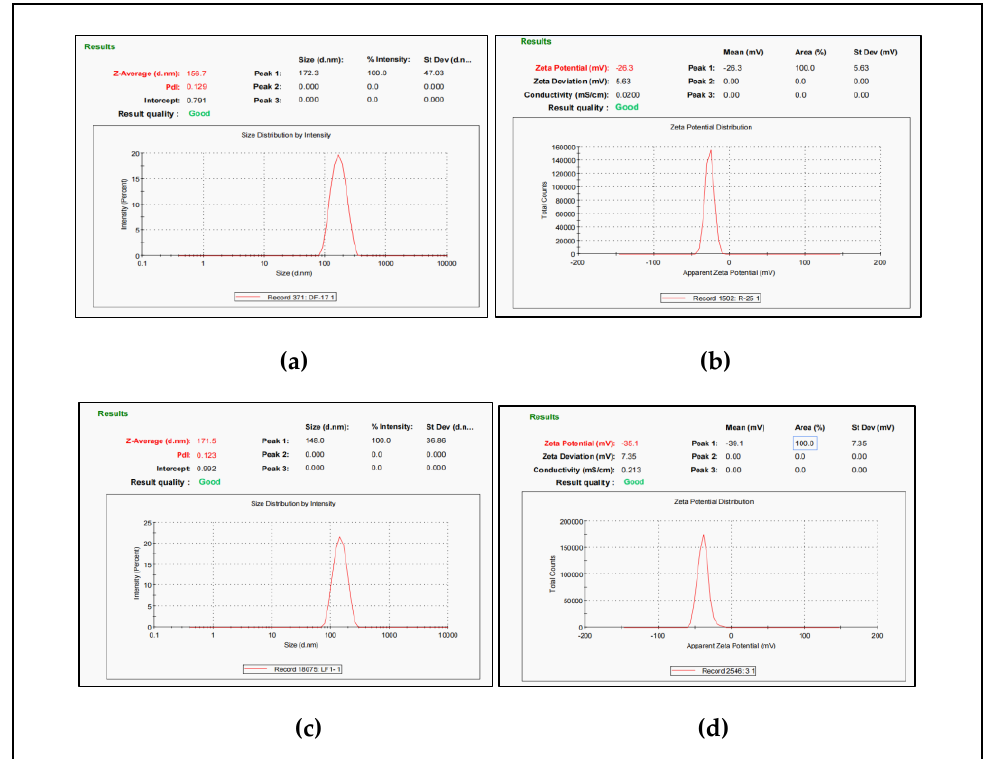
Figure 2. (a) Particle size and PDI of LPs (b) Zeta potential of LPs. (c) Particle size and PDI of Figure 2. ( a ) Particle size and PDI of LPs ( b ) Zeta potential of LPs. ( c ) Particle size and PDI of ADA-LP ADA-LP (d) Zeta potential of ADA-LPs. ( d ) Zeta potential of